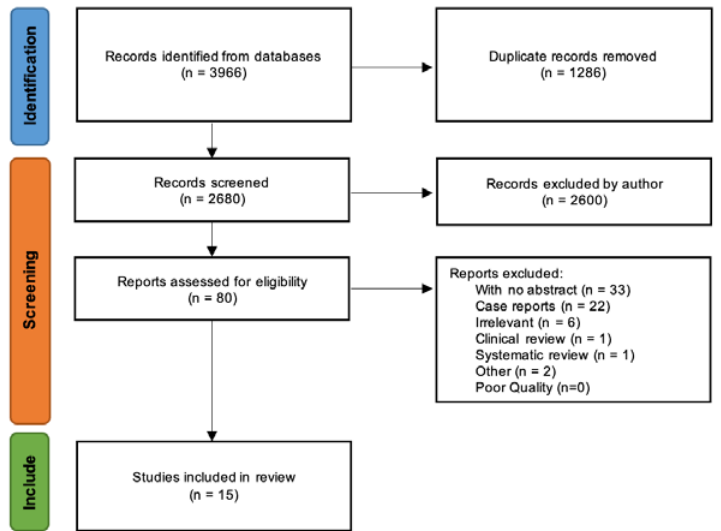
Figure 1. PRISMA flowchart outlining search strategy (PRISMA [5]).